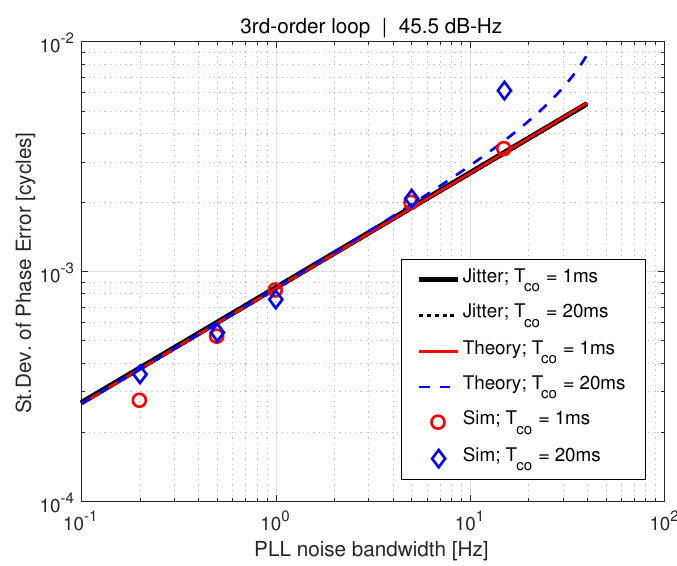
Figure 9. Sigma phase error vs. PLL